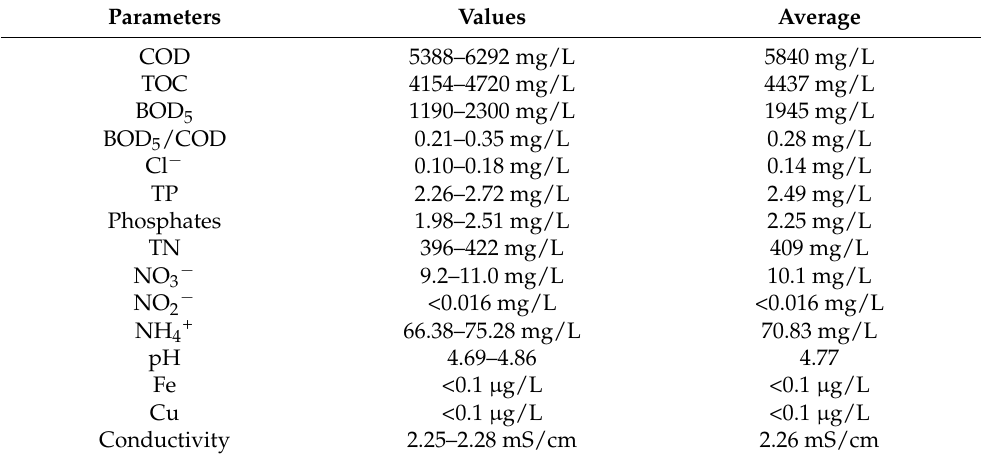
Table 1. Main characteristics of the raw pharmaceutical wastewater used in this